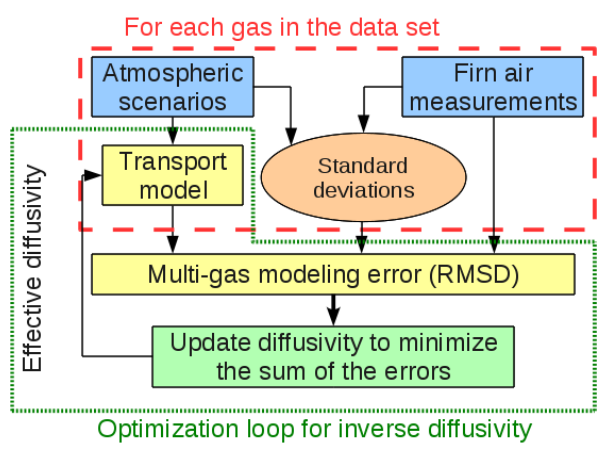
Fig. 3. Multiple gases inverse diffusivity